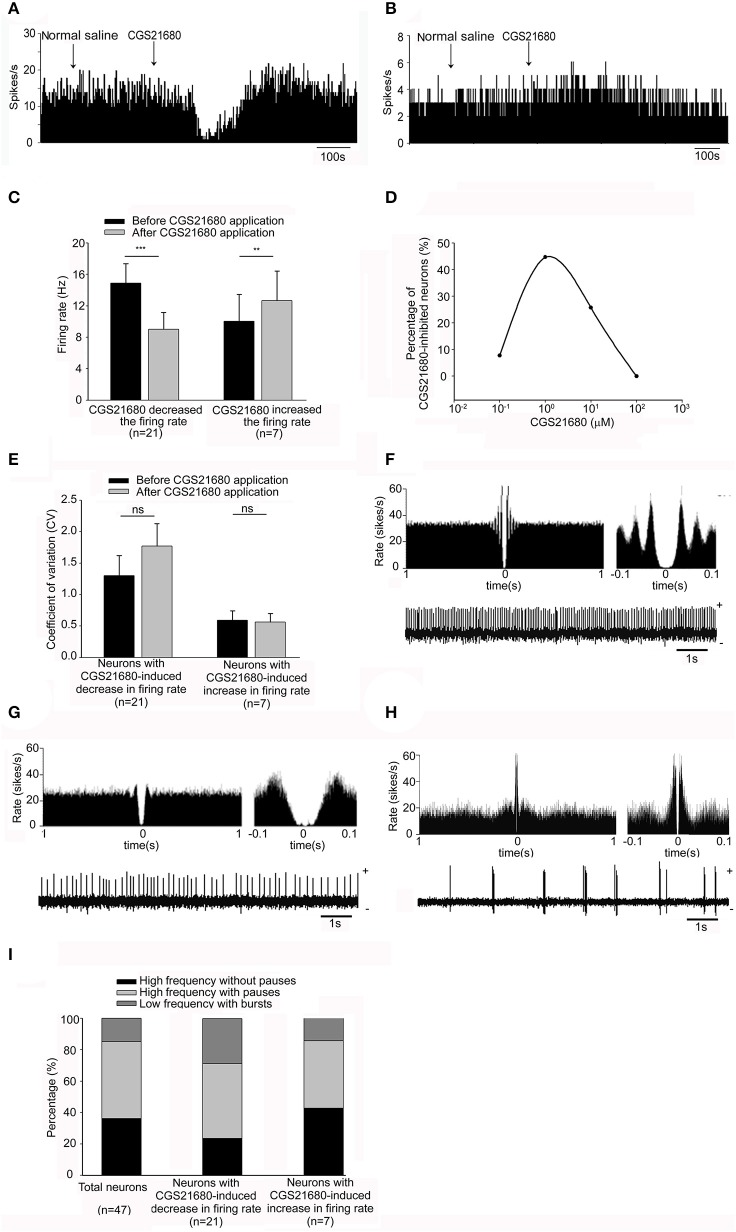
Effects of micro-pressure ejection of adenosine A2A receptor selective agonist, CGS21680, on the spontaneous firing of pallidal neurons in normal rats. (A) Typical frequency histograms showing that 1 μM CGS21680 decreased the firing rate of a pallidal neuron. (B) In this neuron, 1 μM CGS21680 increased the firing rate slightly. (C) Pooled data summarizing the effects of 1 μM CGS21680 on the firing rate of pallidal neurons in normal rats. The black bars represent the basal firing rate before CGS21680 application, while the gray bars represent the firing rate after CGS21680 application. **P < 0.01, ***P < 0.001, paired-samples t-test. (D) The graph summarizing the percentages of pallidal neurons with different concentrations (0.1, 1, 10, and 100 μM) of CGS21680-induced decrease in firing rate. (E) Pooled data summarizing the effects of CGS21680 on the CV of pallidal neurons. (F–H) Typical traces showing three firing patterns of globus pallidus neurons, high frequency without pauses (F), high frequency with pauses (G), and low frequency with bursts (H). (I) Pooled data showing the proportion of the three firing pattern types in total neurons and CGS21680-induced inhibitory or excitatory neurons.